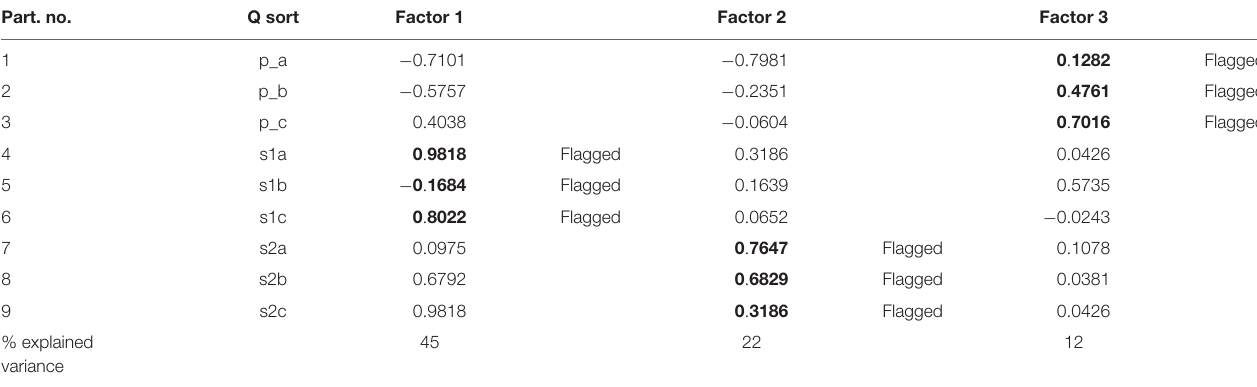
TABLE 1 | Factor matrix with defining sorts flagged: Factor 1 is flagged for Secondary 1, factor 2 is flagged for Secondary 2, and factor 3 is flagged for Primary. Part. no.